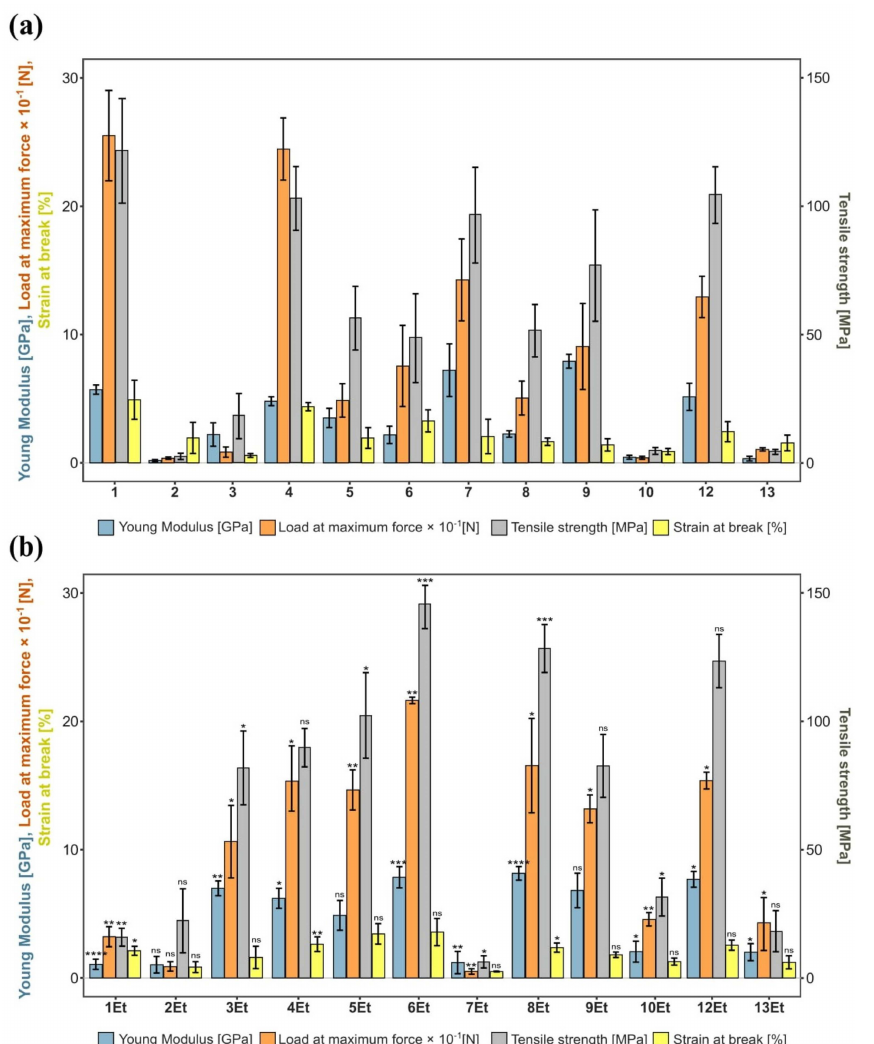
Figure 2. The results of biomechanical measurements when breaking bacterial cellulose membranes produced by 12 Komagataeibacter strains ( a ) without and ( b ) with ethanol supplementation. Statistically significant differences were calculated using Student’s t test and shown as * = p ≤ 0.05, ** = p ≤ 0.01, and *** = p ≤ 0.001, compared to BNC synthesized without